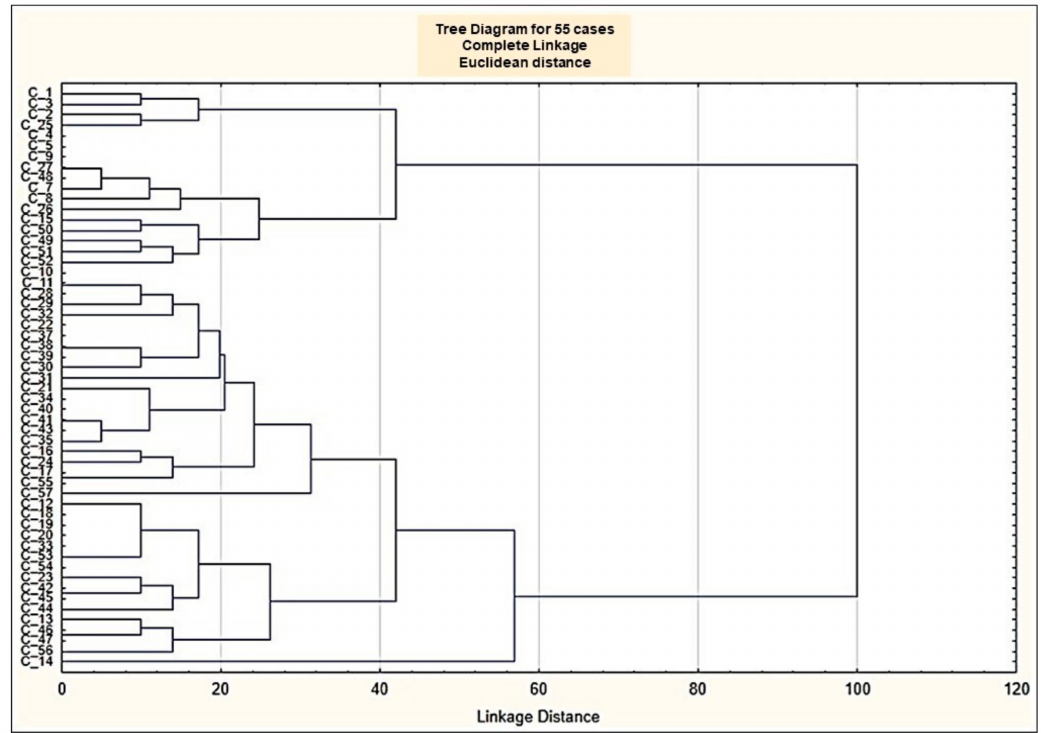
Figure 2. The hierarchical clustering dendrogram of potato genotypes. Potato genotypes: n = 55. C_1, Alpha; C_2,